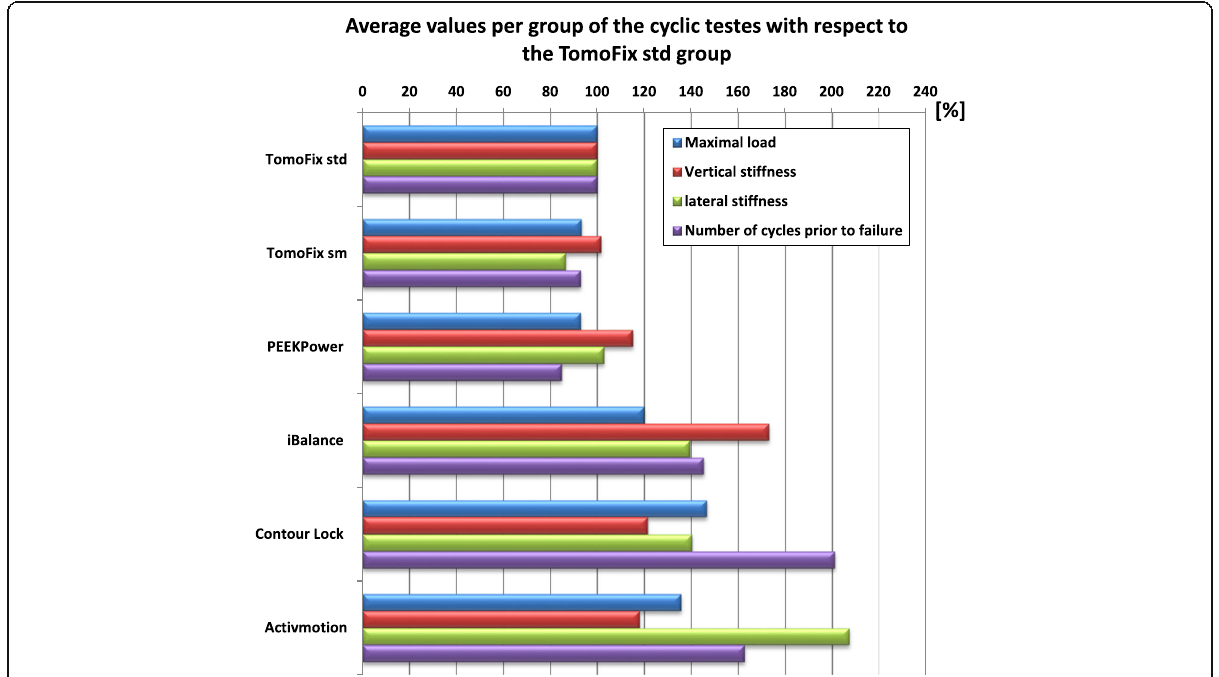
Fig. 9 Average relative strength values: The TomoFix std. group has been taken as